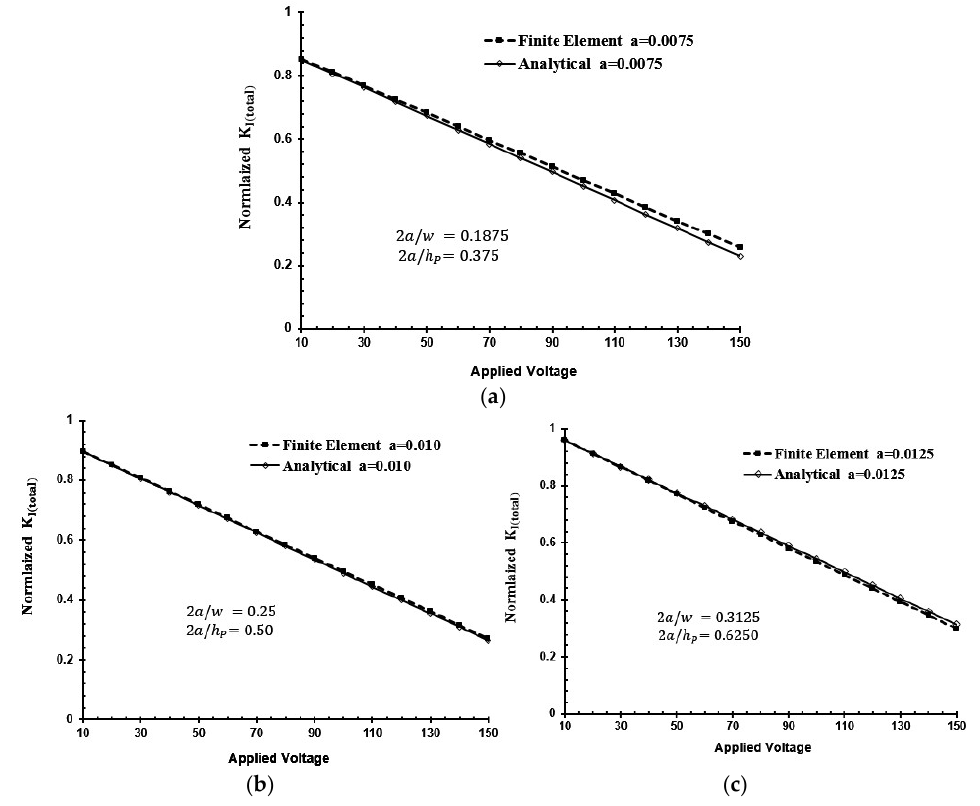
Figure 7. Variation of the normalized SIF with the crack length ( a ) crack length a=0.0075 m, ( b ) a=0.010 m, ( c ) a=0.0125 m